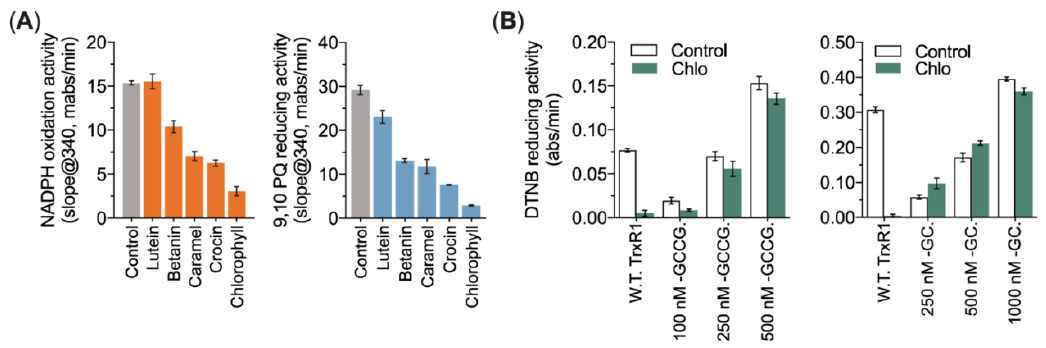
Figure 3. Identification of the Sec 498 residue of TrxR1 targeted by chlorophyll. ( A ) Food colorants inhibited the juglone reducing activity and the 9,10 PQ reducing activity of TrxR1. TrxR1 was pre-reduced with 100 µM NADPH for 10 min, and then, 500 µM different food colorant were incubated with TrxR1 in dark for 30 min, respectively. Subsequently, the TrxR1 activity of juglone and 9,10 PQ as substrates was determined. ( B ) Chlorophyll has no inhibition on either TrxR1 Sec-to-Cys mutant or the UGA-truncated mutant. Wild type TrxR1, GCCG variants (1 µM, 2.5 µM, 5 µM) and truncated TrxR1 (2 µM, 5 µM, 10 µM) were incubated with 500 µM Chlorophyll for 60 min. After incubation, the enzyme activity was determined by using DTNB as substrate.